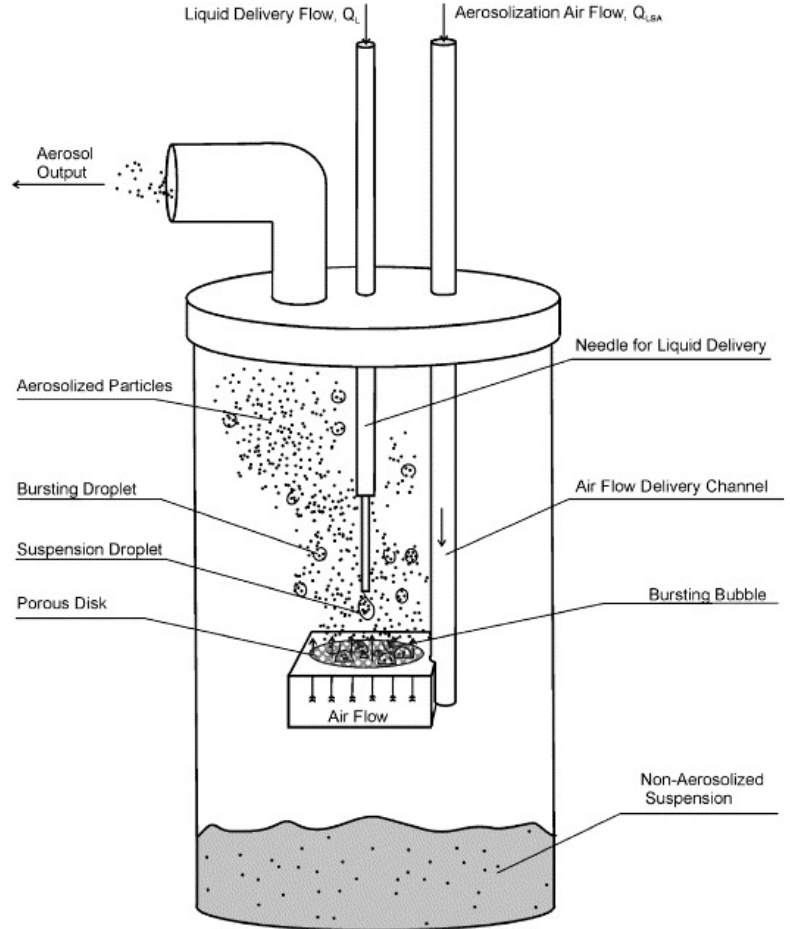
Figure 15. Schematic diagram of collision nebulizer (reprinted with ELSEVIER PERMISSION—License Number 4834190009888).